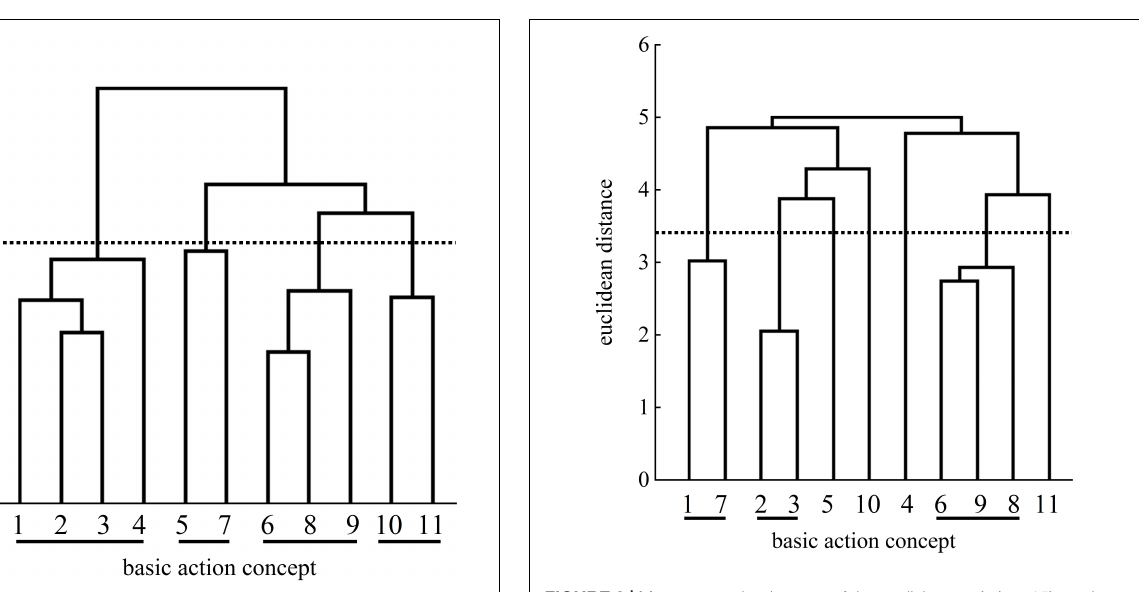
FIGURE 6 | Mean group dendrogram of the analogy group’s ( n = 15) tennis serves on the retention test.